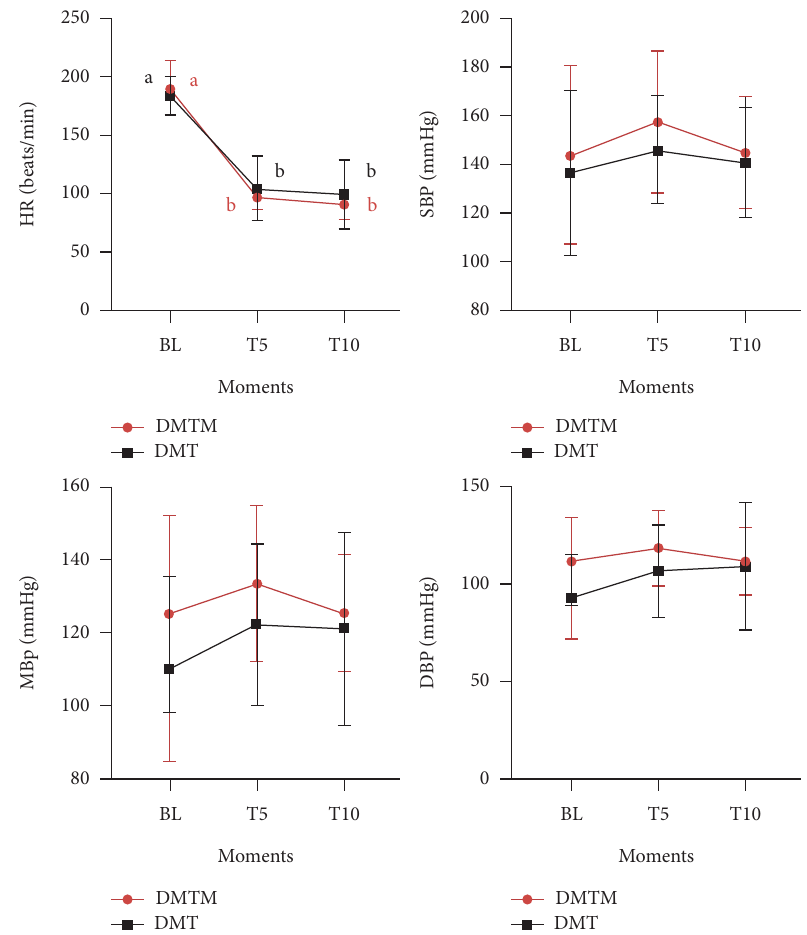
Figure 1: Values of heart rate (HR) and systolic, diastolic, and mean blood pressure (SBP, DBP, MBP, respectively), in 18 felines sedated with the association of dexmedetomidine (7.5ug/kg) and methadone (0.3mg/kg) (DMT, n � 9) or dexmedetomidine (5ug/kg), methadone (0.3mg/kg), and midazolam (0.3mg/kg) (DMTM, n � 9), both by the intramuscular route. Values are presented as mean ± standard deviation. a, b: diferent lowercase letters indicate signifcant diferences between moments inside the same group according to Tukey test ( p < 0 . 05).